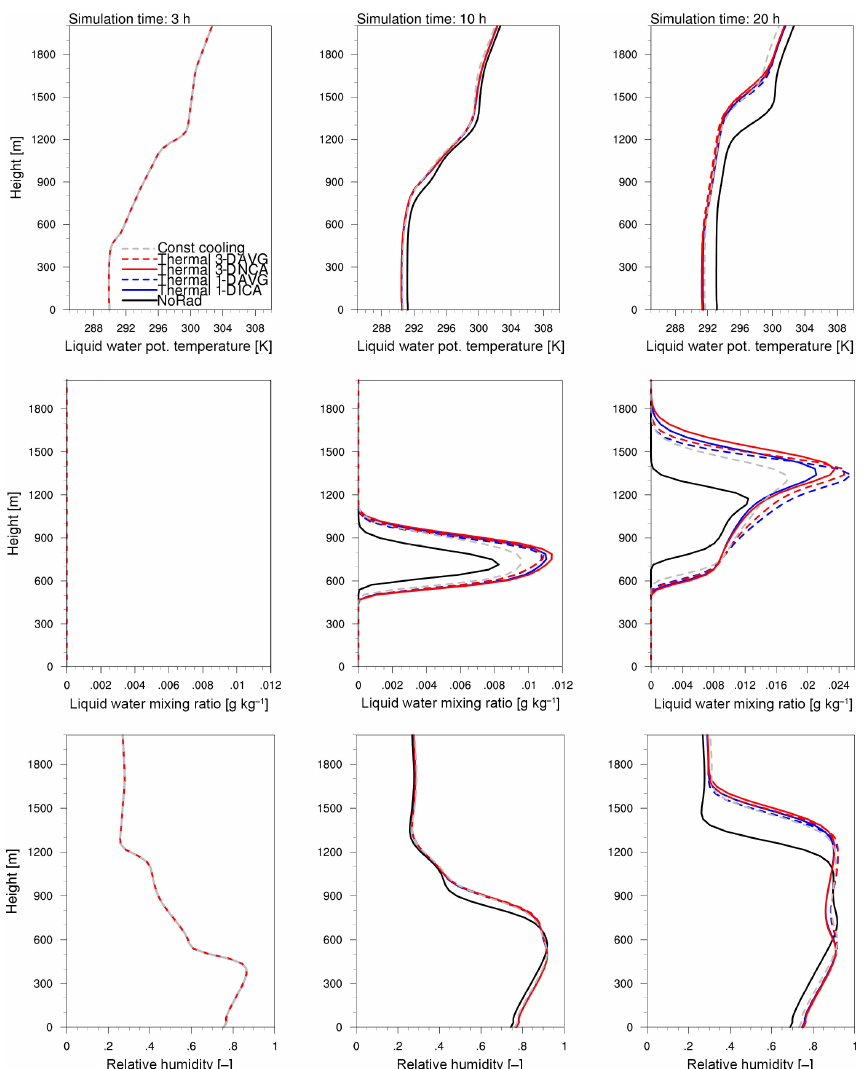
Figure 10. Time-averaged profiles of liquid water potential temperature, liquid water mixing ratio and relative humidity. The profiles are shown at the restart time (3h) as a 3h average centered at 10 and 20h of the